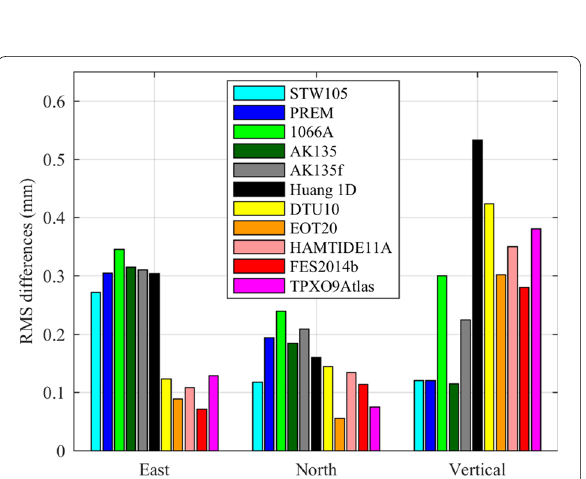
Fig. 12 RMS differences of the modeled M 2 OTL displacements between different model combinations. The RMS differences of the modeled M 2 OTL displacements are computed between different ocean tide models and FES2014b (the Earth model is TW1), as well as between different Earth models and PREM (the ocean tide model is